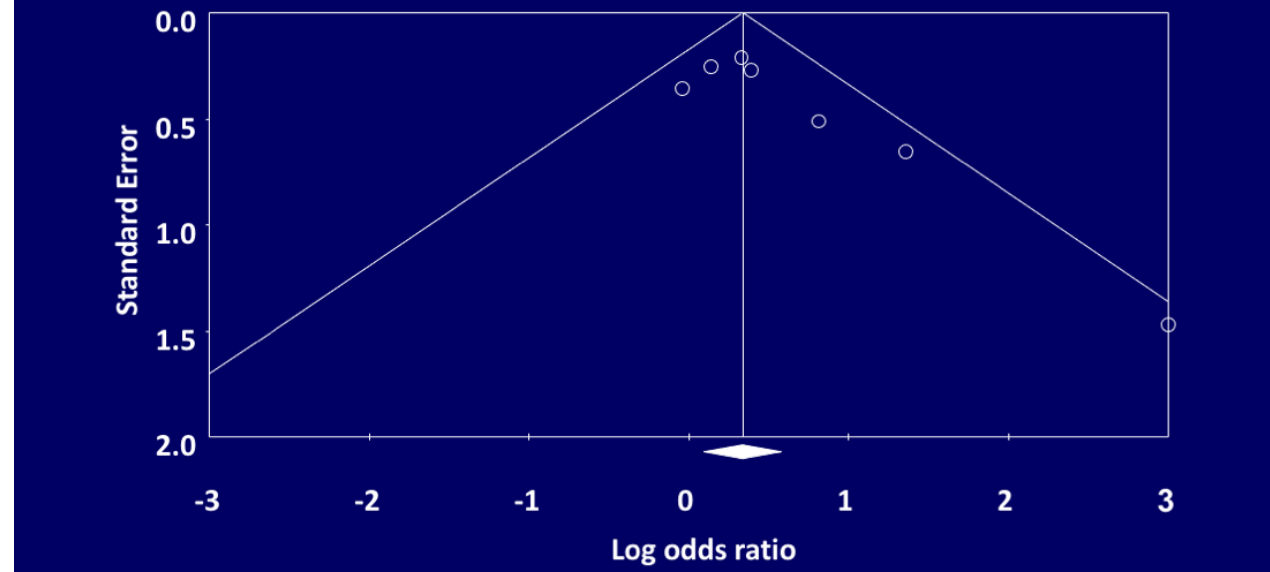
Figure 4. Funnel Plot of Standard Error by Logs Ratio for Non-Union.